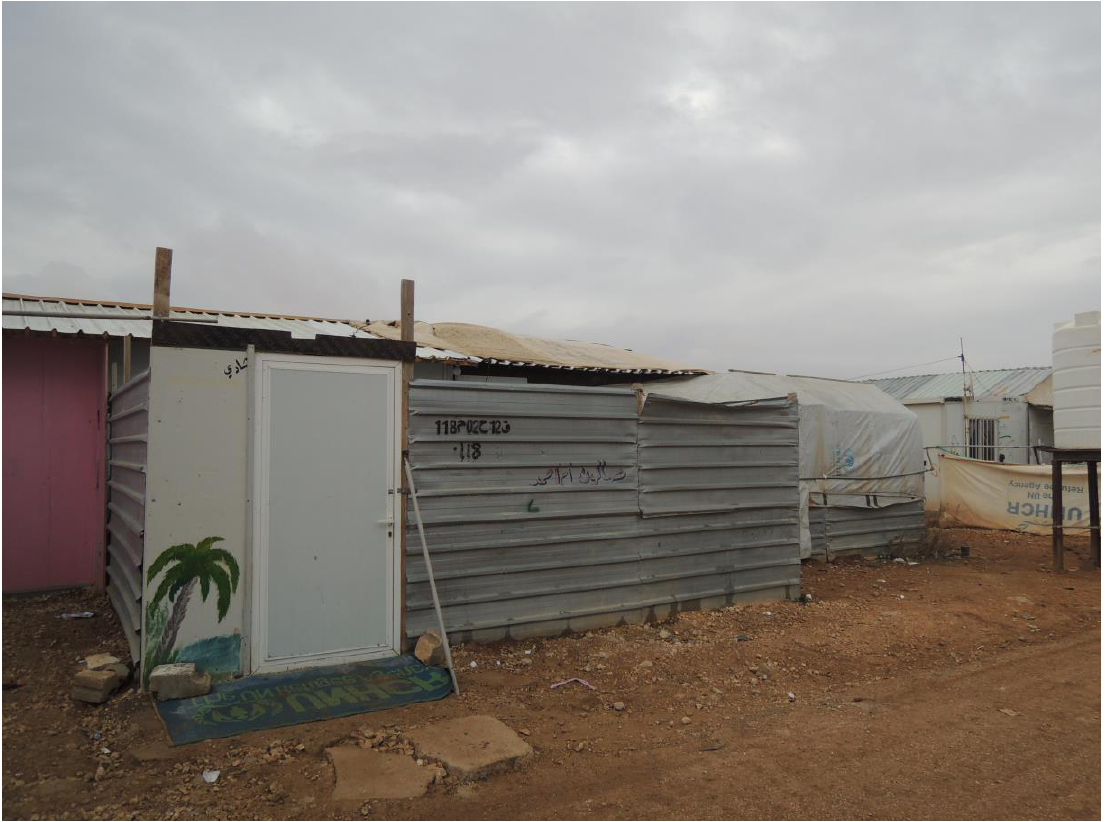
Figure 4. Salon Um-Ahmad for brides with a pink door attached to their house (Source: Author, 2017).